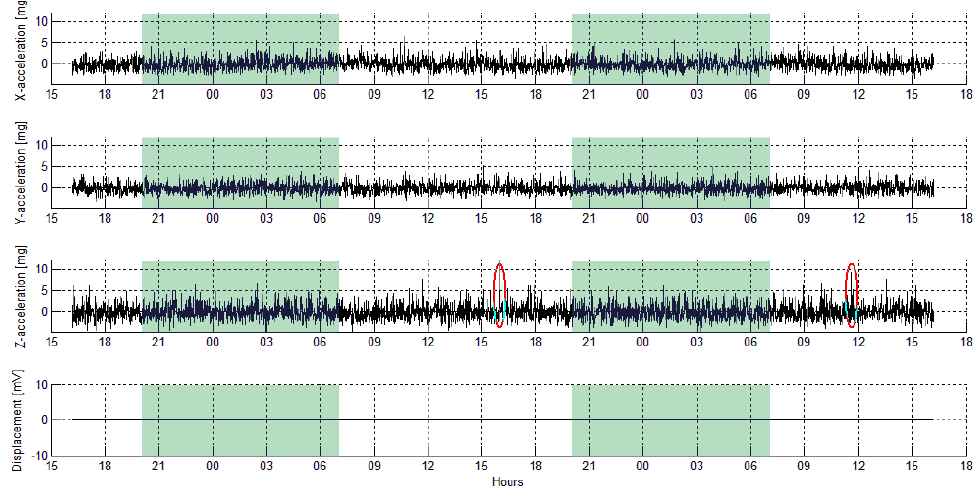
Figure 14. Results registered by node 3 (2-day interval).